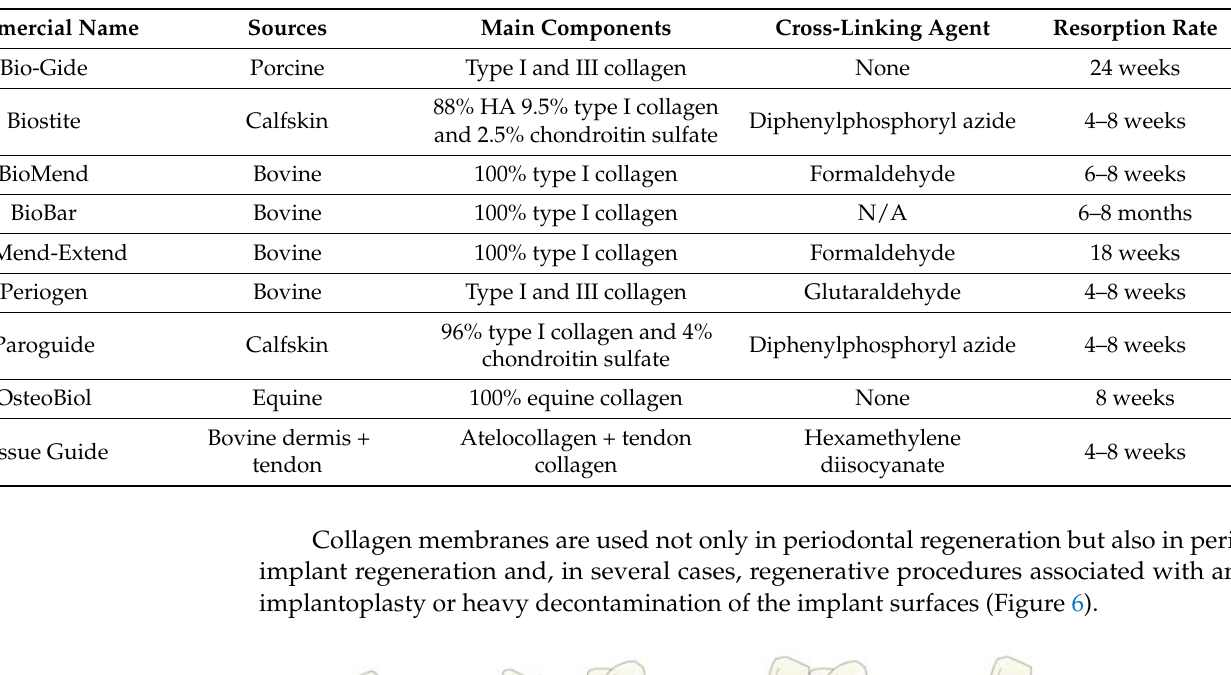
Table 2. Collagen membranes classified according to the sources, main components, and cross-linking agent, as reported on the manufacturing instructions.